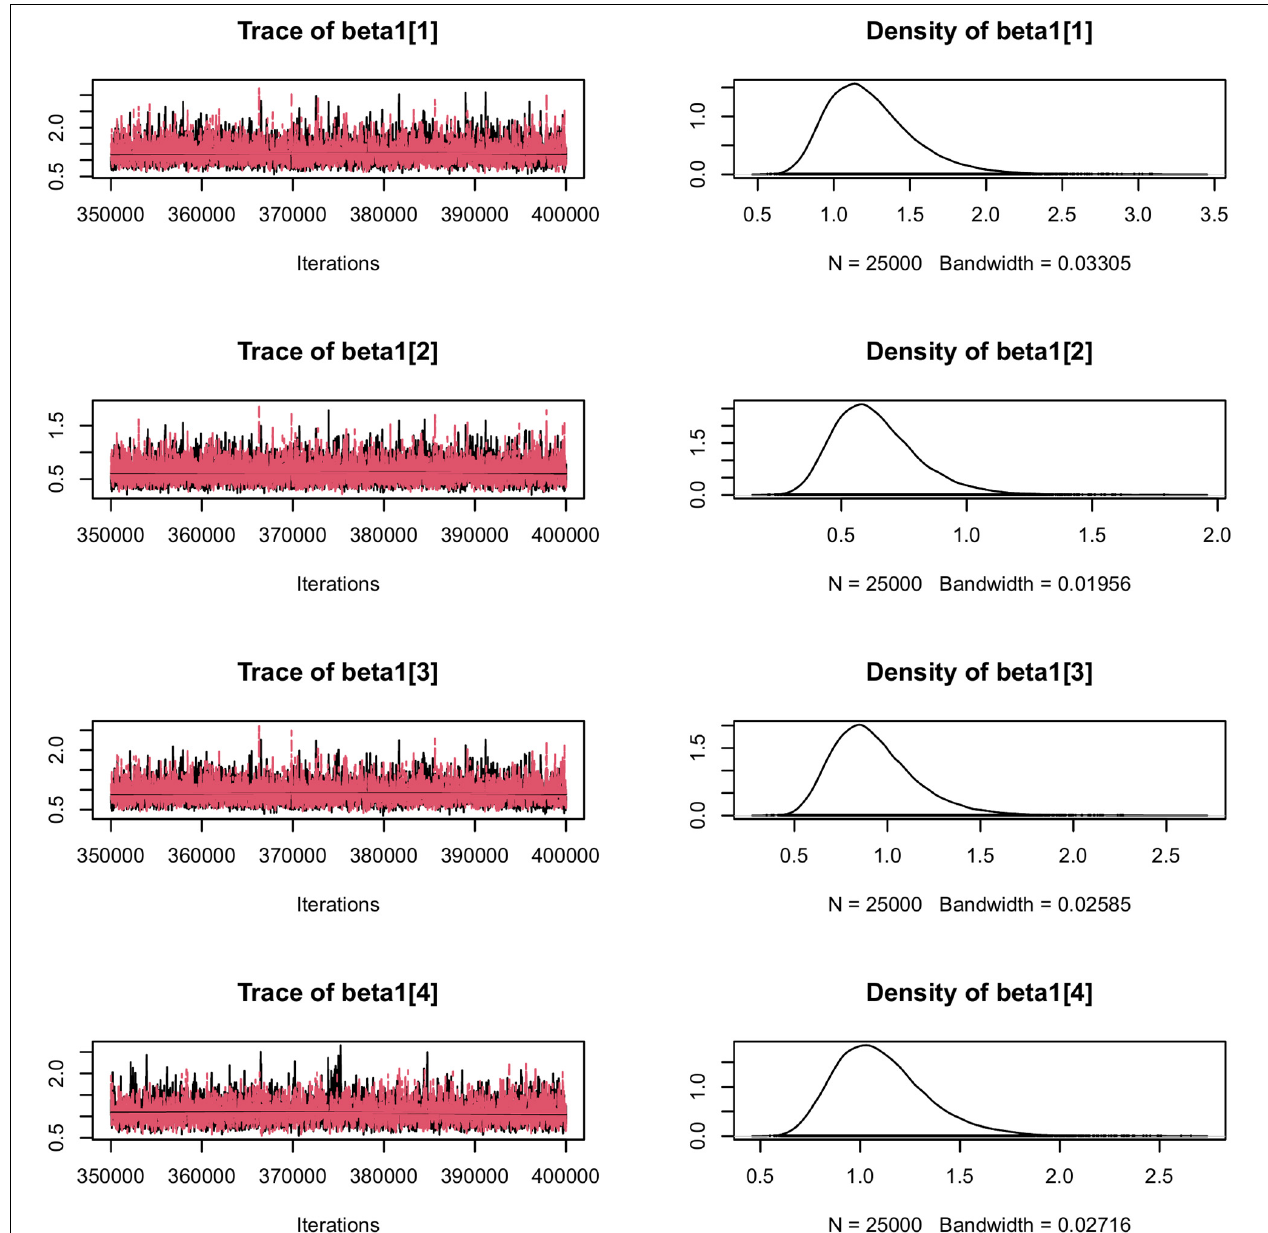
FIGURE 1 | The traces for model convergence and the posterior distributions of a portion of Model 1